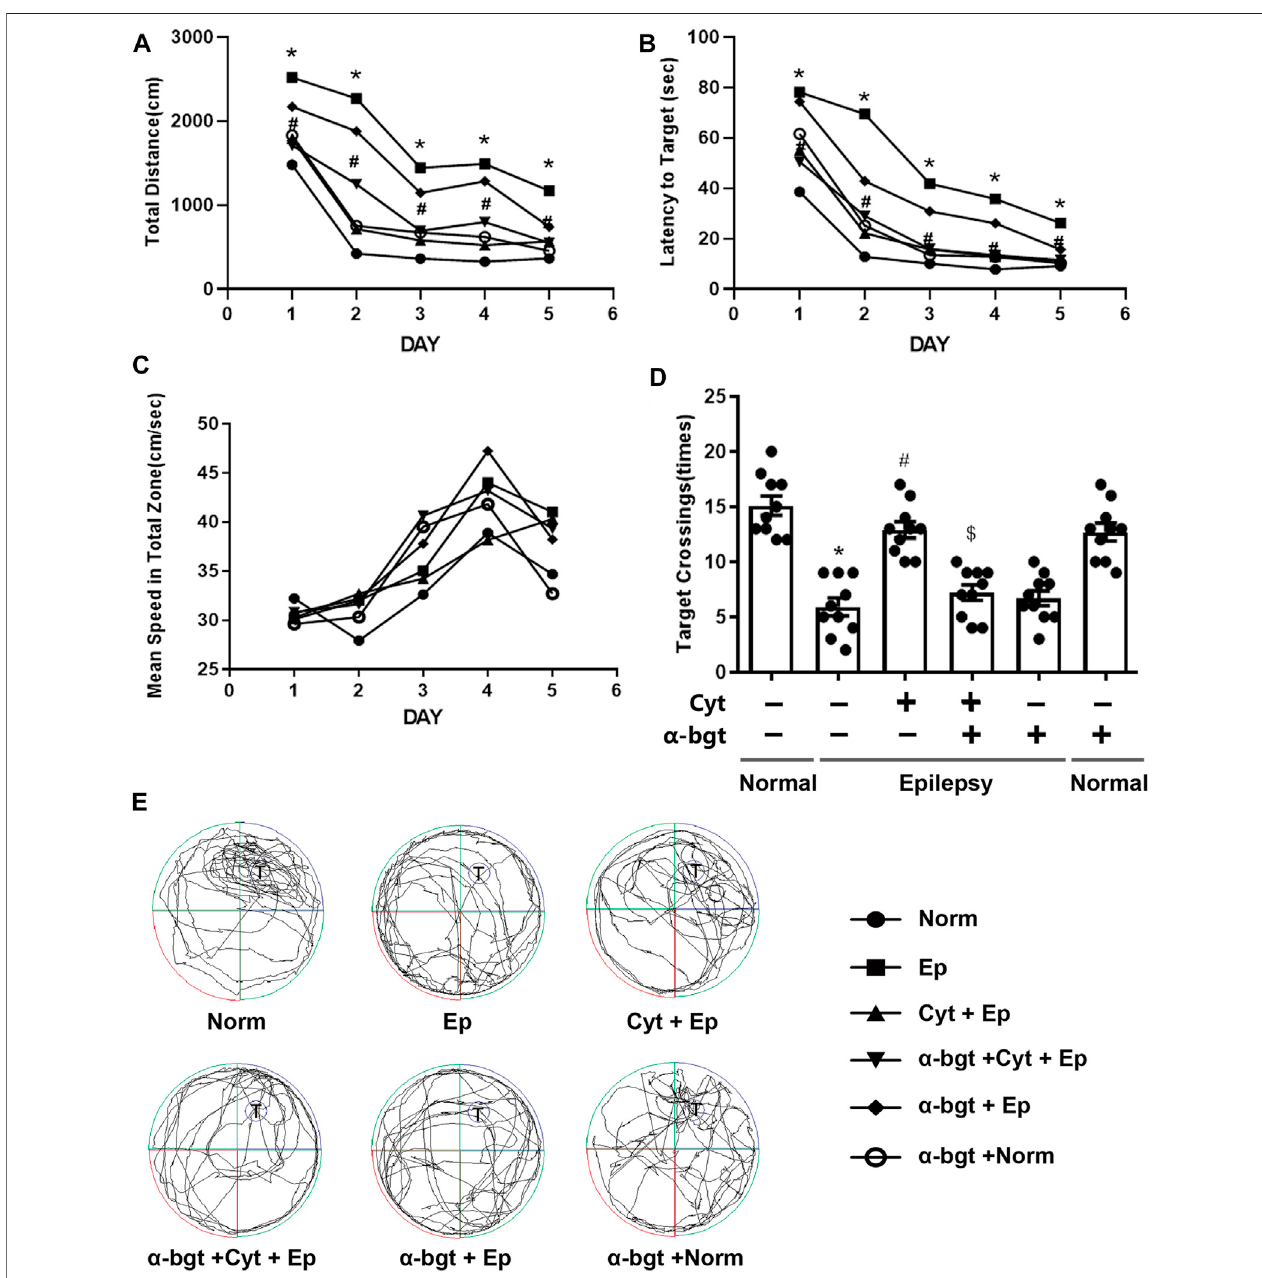
FIGURE 1 | Cytisine ameliorates de fi cits in learning and memory in TLE rats . The effects of cytisine on learning and memory in rats were evaluated using the Morris water maze. A – C: Acquisition training. A: Swim path distance. B: Latency to reach underwater platform. C: Mean swim speed. D – E: Probe trial. D: The number of crossing over the target quadrant. E: Searching trajectories for the target quadrant (T: target). Statistical results are as follows: F (5,54) (cid:1) 26.017, n (cid:1) 10; normal vs. epilepsy, * p < 0.05; epilepsy vs. epilepsy + Cyt, # p < 0.05; epilepsy + Cyt vs. epilepsy + Cyt + α -bgt, $ p < 0.05.